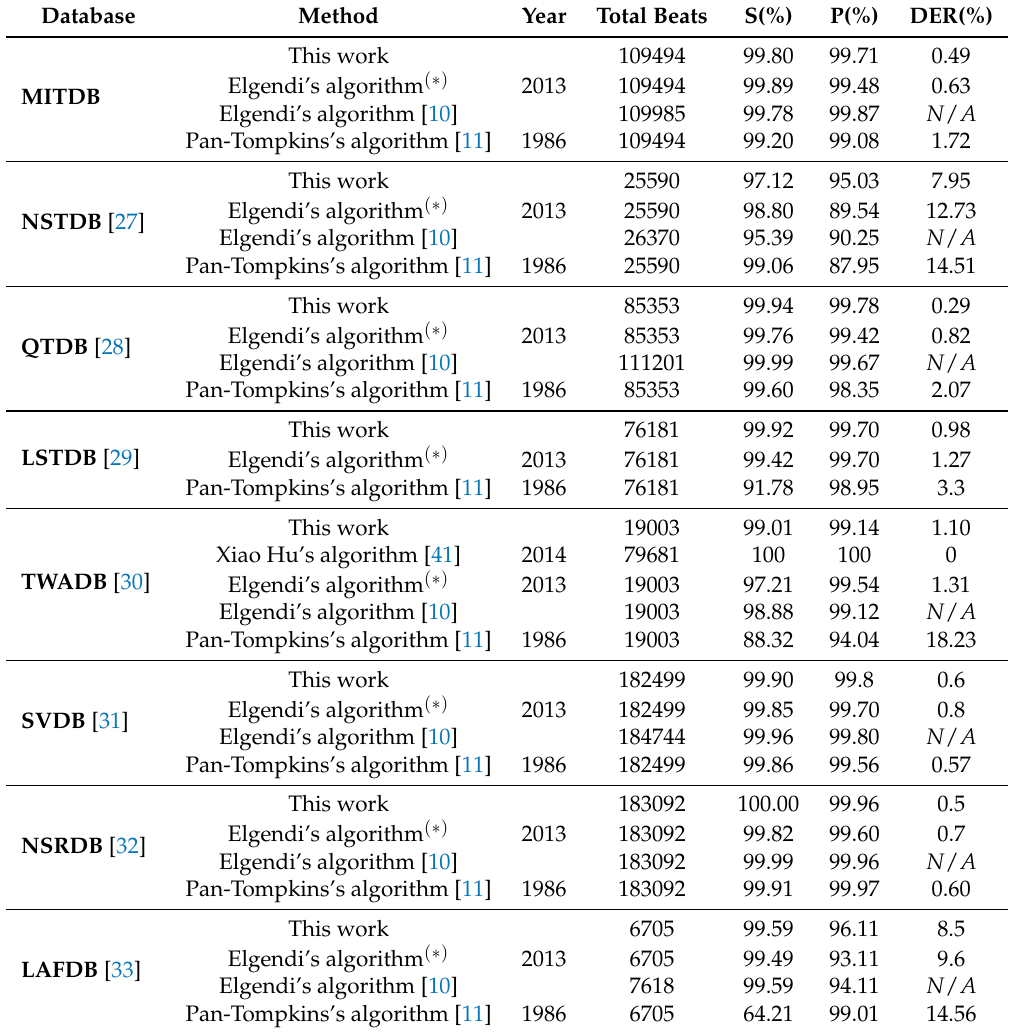
Table 5. Performance comparison between the proposed method and other state-of-art methods. (*) The results from our implementation and beat-by-beat comparison using AAMI standard [26].